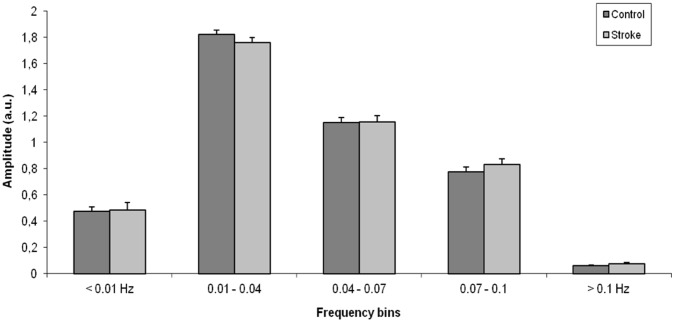
Average power spectrum (± SEM) of the time course of the independent component that belongs to the default mode network is shown for both control and stroke subjects.The highest power density was observed in the low frequency domain (0.01–0.04 Hz) for both groups. No significant differences in frequency characteristics were observed between the control and stroke subjects.